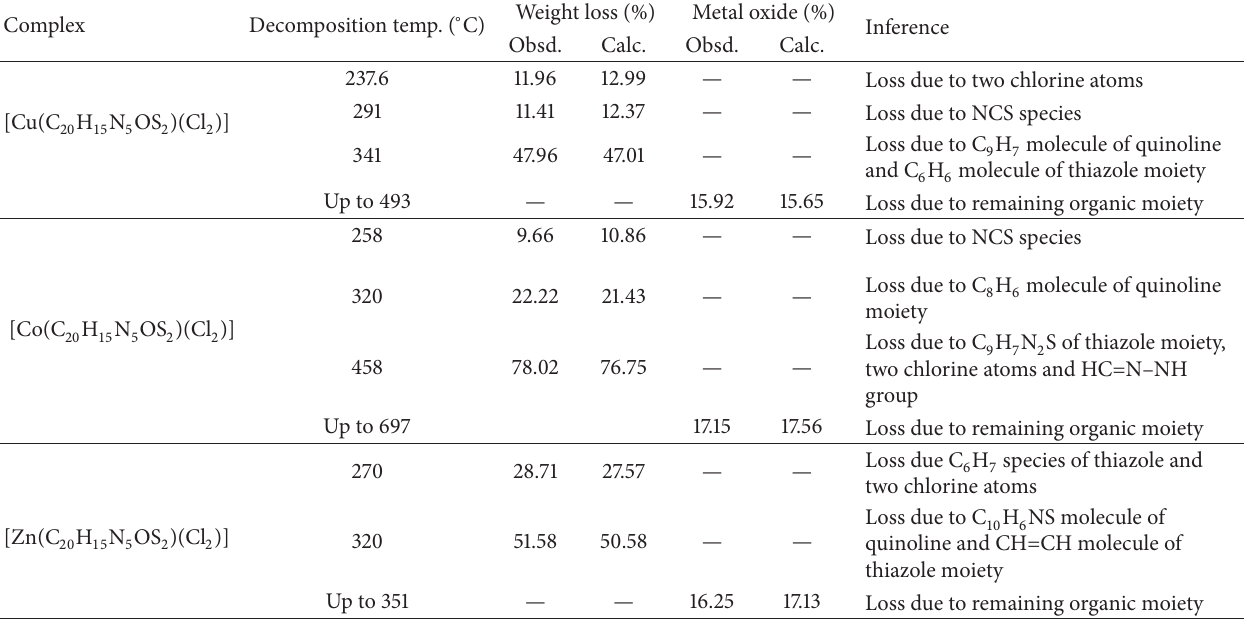
Table 4: Thermal data of Cu(II), Co(II) and Zn(II) complex.